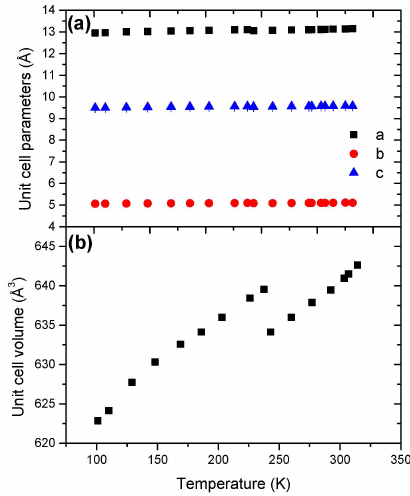
Figure 4. Temperature dependence of ( a ) the unit cell parameters and ( b ) the unit cell volume for HB in the temperature range 101–314 K.